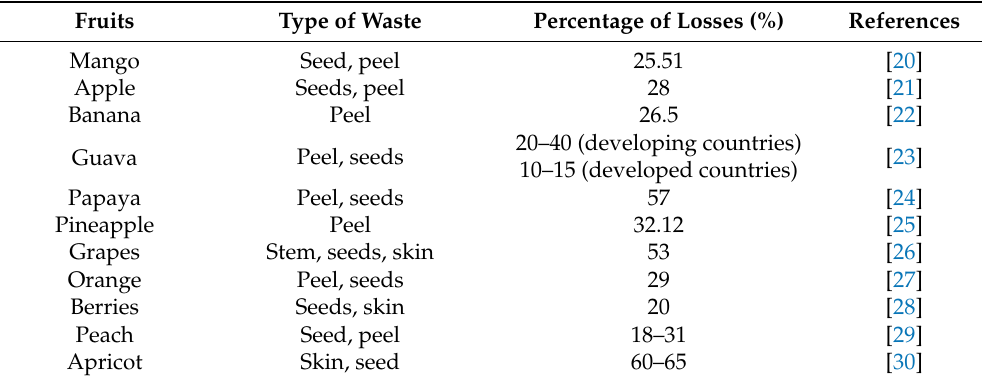
Table 1. Summary of different fruit losses and waste